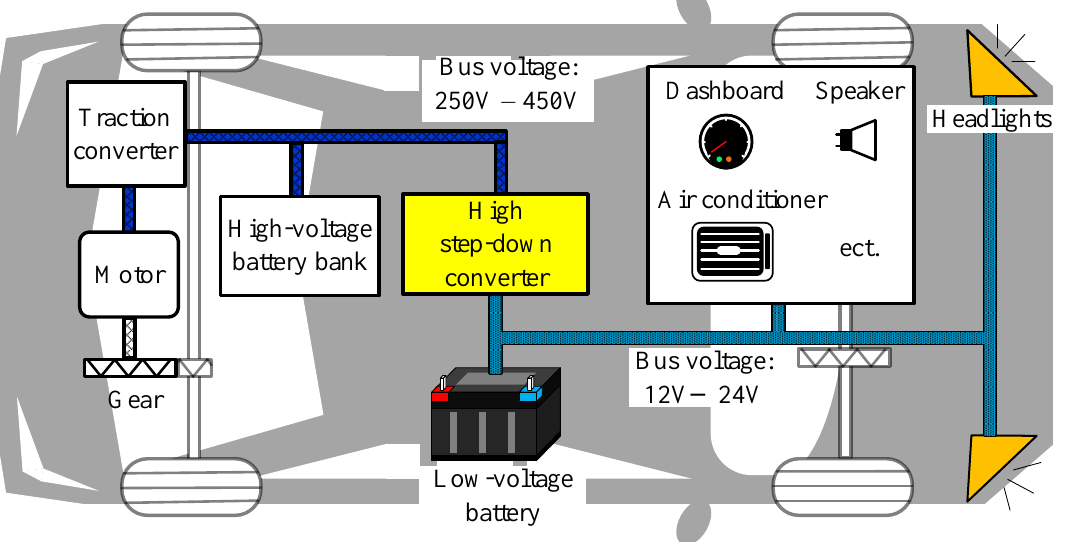
Figure 1. Structure of the power system of electric vehicles.